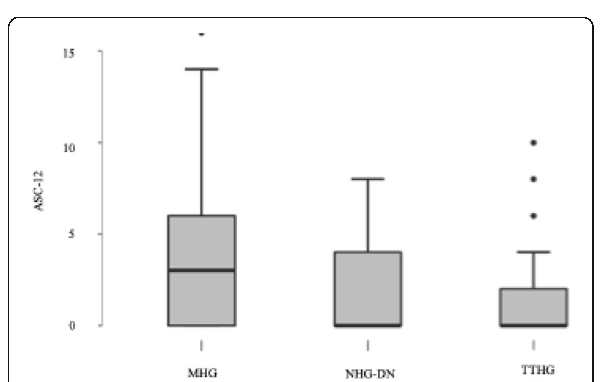
Fig. 2 (abstract P036). See text for